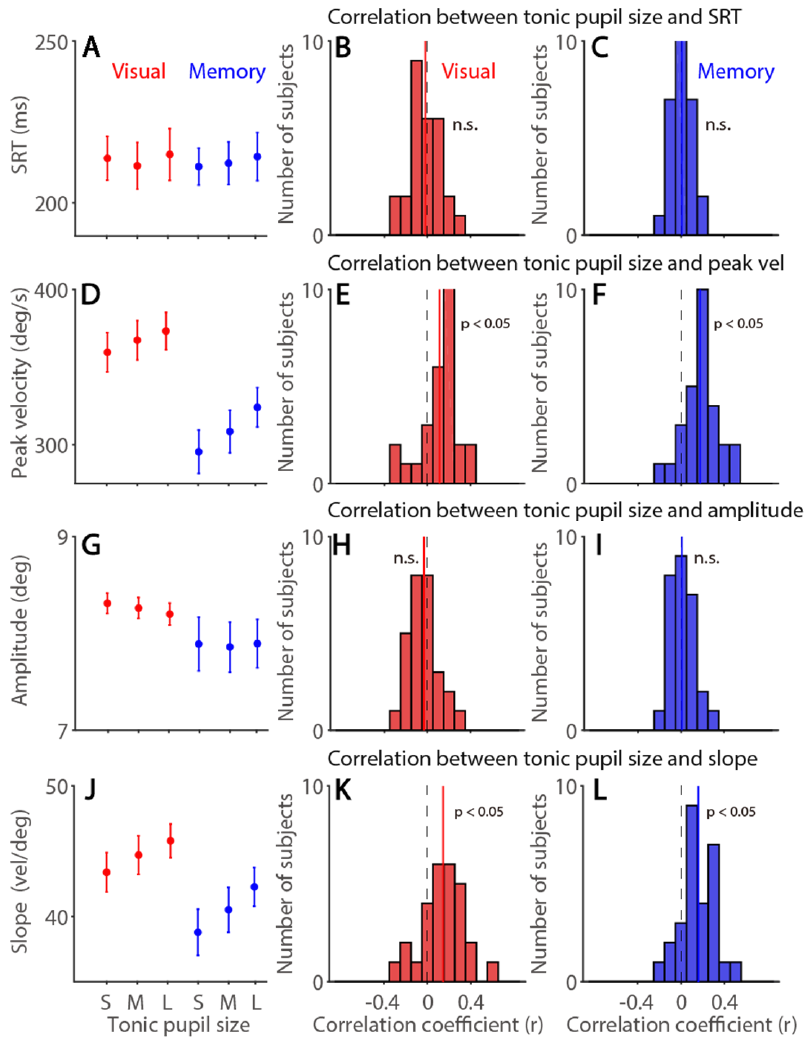
Figure 4. Tonic pupil size effects on visually and memory-guided saccade latency and metrics. ( A ) SRTs at different tonic pupil size conditions. ( B , C ) Distribution of correlation coefficients for the relationship between tonic pupil size and SRT in visually guided ( B ) and memory-guided ( C ) saccades for all subjects ( n = 28). ( D ) Saccade peak velocity at different tonic pupil size conditions. ( E , F ) Distribution of correlation coefficients for the relationship between tonic pupil size and saccade peak velocity in visually guided ( E ) and memory-guided ( F ) saccades for all subjects. ( G ) Saccade amplitude at different tonic pupil size conditions. ( H , I ) Distribution of correlation coefficients for the relationship between tonic pupil size and saccade amplitude in visually guided ( H ) and memory-guided ( I ) saccades for all subjects. ( J ) Main sequence slope (peak velocity/amplitude) at different tonic pupil size conditions. ( K , L ) Distribution of correlation coefficients for the relationship between tonic pupil size and slope in visually guided ( K ) and memory-guided ( L ) saccades for all subjects. The error bars represent ± standard error range (across participants). The vertical black dashed line represents a zero value of the correlation coefficient (r = 0), and the vertical colored line represents the mean value of the correlation coefficient. Visual: visually guided saccade task. Memory: memory-guided saccade task. S: small, M: mid, L: large. SRT: saccade reaction times. n.s.: not